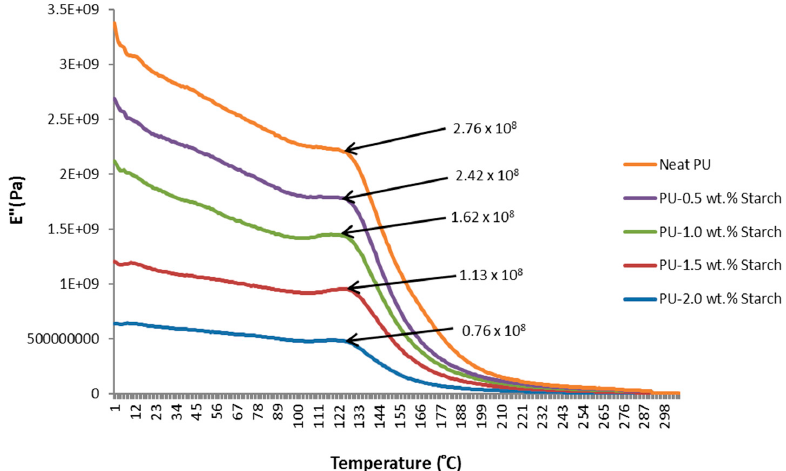
Figure 8. Loss modulus of PU and PUS composites.